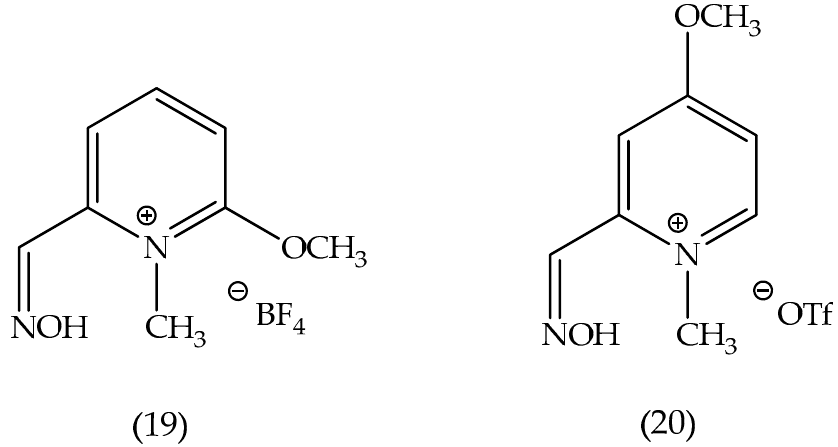
Figure 13. Representation of the chemical structure of some molecules synthesized.